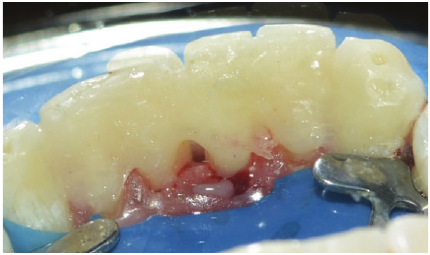
Figure 8: Postoperative palatal view.